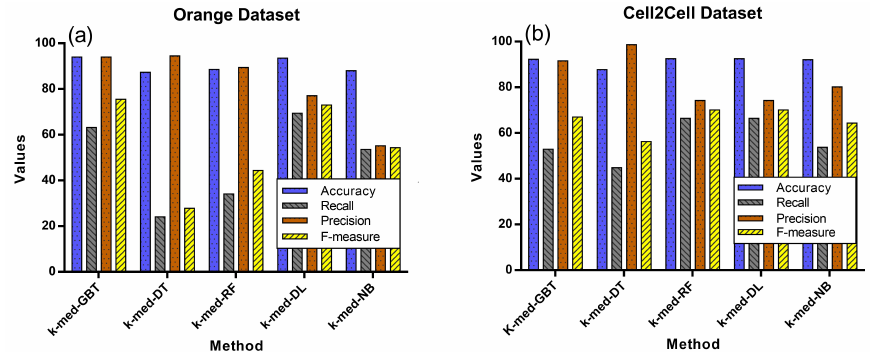
Figure 4. Depicts clustering and classification-based hybrid model performance ( a ) Hybrid model results using Orange dataset. ( b ) Hybrid model results using Cell2Cell dataset.